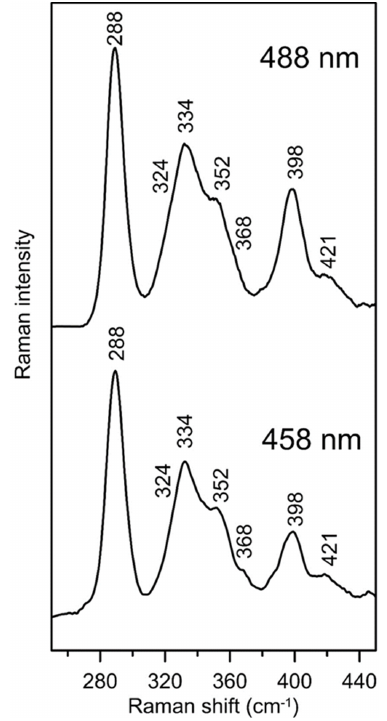
Figure 6. Resonance Raman spectra of [2Fe-2S] 2+ cluster-bound as-isolated At ISCA1a/2 using 458-nm and 488-nm laser excitation . The sample (~2 mM [2Fe-2S] 2+ clusters) in 100 mM Tris-HCl buffer at pH 7.8 was in the form of a frozen droplet at 17 K. The spectrum is the sum of 100 individual scans with each scan involving photon counting for 1 s at 0.5 cm − 1 increments with 7 cm − 1 spectral resolution. Bands due to lattice modes of the frozen buffer solution were subtracted from both spectra. Table 1. Fe-S stretching frequencies (cm − 1 ) and vibrational assignments for the [2Fe-2S] 2+ clusters in A. thaliana ISCA1a/2, A. vinelandii Nif IscA and Spinacia oleracea ferredoxin.